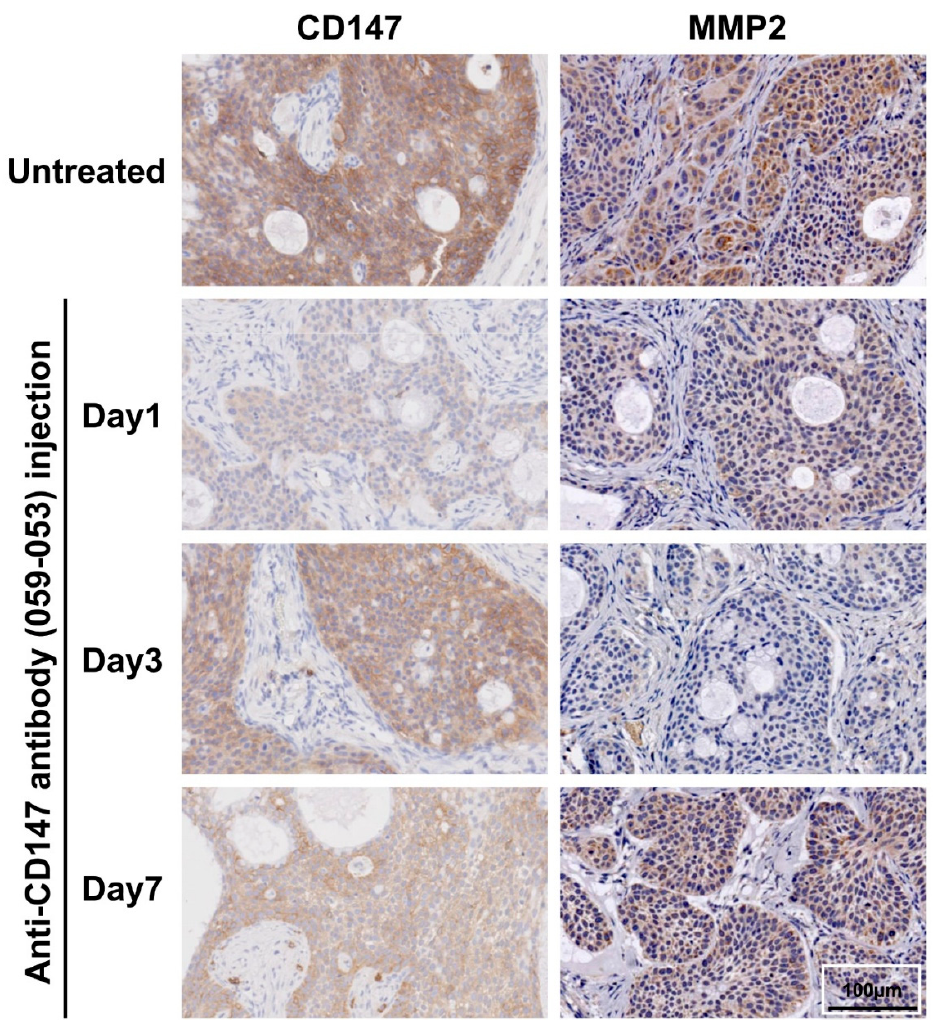
Figure 1. Immunohistochemical staining of CD147 and MMP2 in BxPC-3 xenografted tumors at days 1, 3, and 7 after i.v. injection of intact anti-CD147 antibody 059-053 (25 µ g). Sections were immunostained with a goat anti-EMMPRIN/CD147 antibody (diluted 1:500) or an anti-MMP2 polyclonal antibody (diluted 1:200) as the primary antibody.